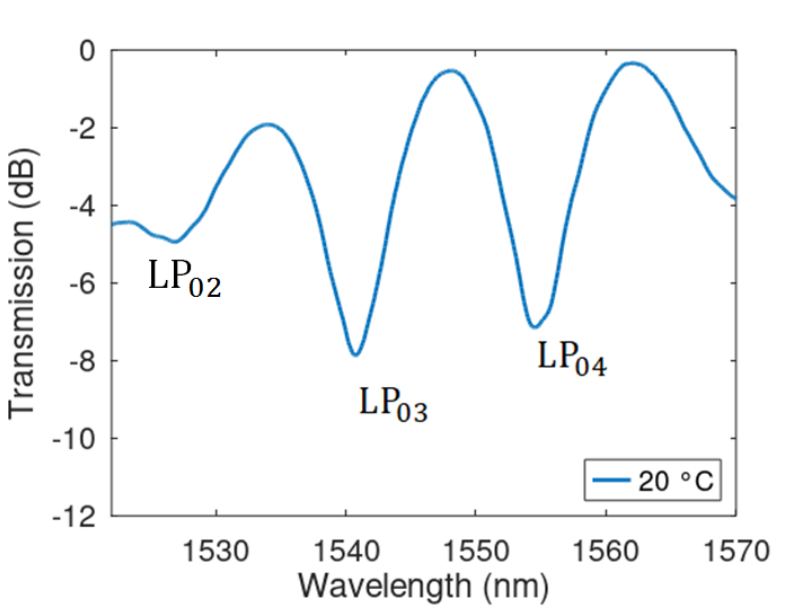
Figure 6. Spectral response of the fabricated LPFG. The spectra show the three low − order cladding modes LP 02 , LP 03 , LP 04 at 1525, 1541, and 1555 nm, respectively.